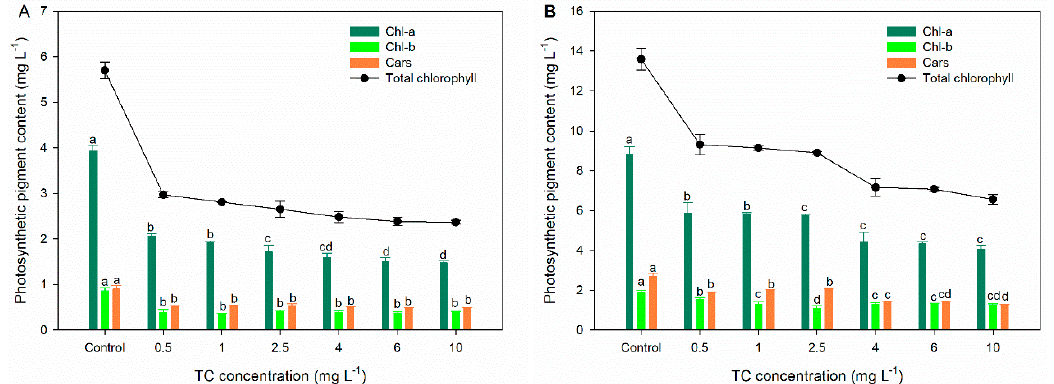
Figure 2. Effects of TC on the Chl-a, Chl-b, Cars, and total chlorophyll of C. pyrenoidosa after 48 ( A ) and 96 h ( B ) of exposure in different treatments. The different letters indicate significant differences ( p < 0.05) between the control and experimental treatments.